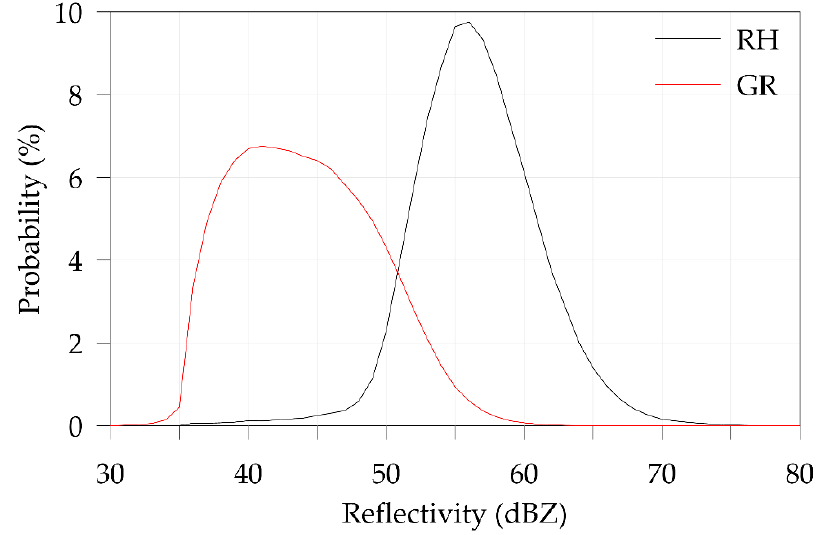
Figure 1. The probability distributions of reflectivity versus the RH and GR output from the HC algorithm.